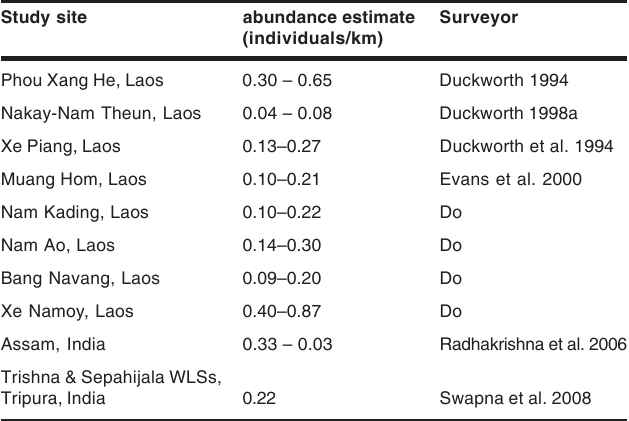
Table 2: Bengal Slow Loris abundance rate in other areas Study